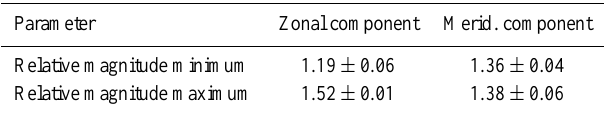
Table 6. Mean and standard deviation of daily relative magnitude minima and maxima for HDI relative to DBS from 18 June 1998 to 29 June 1998. Parameter Zonal component Merid. component Relative magnitude minimum 1 . 19 ± 0 . 06 1 . 36 ± 0 . 04 Relative magnitude maximum 1 . 52 ± 0 . 01 1 . 38 ± 0 . 06